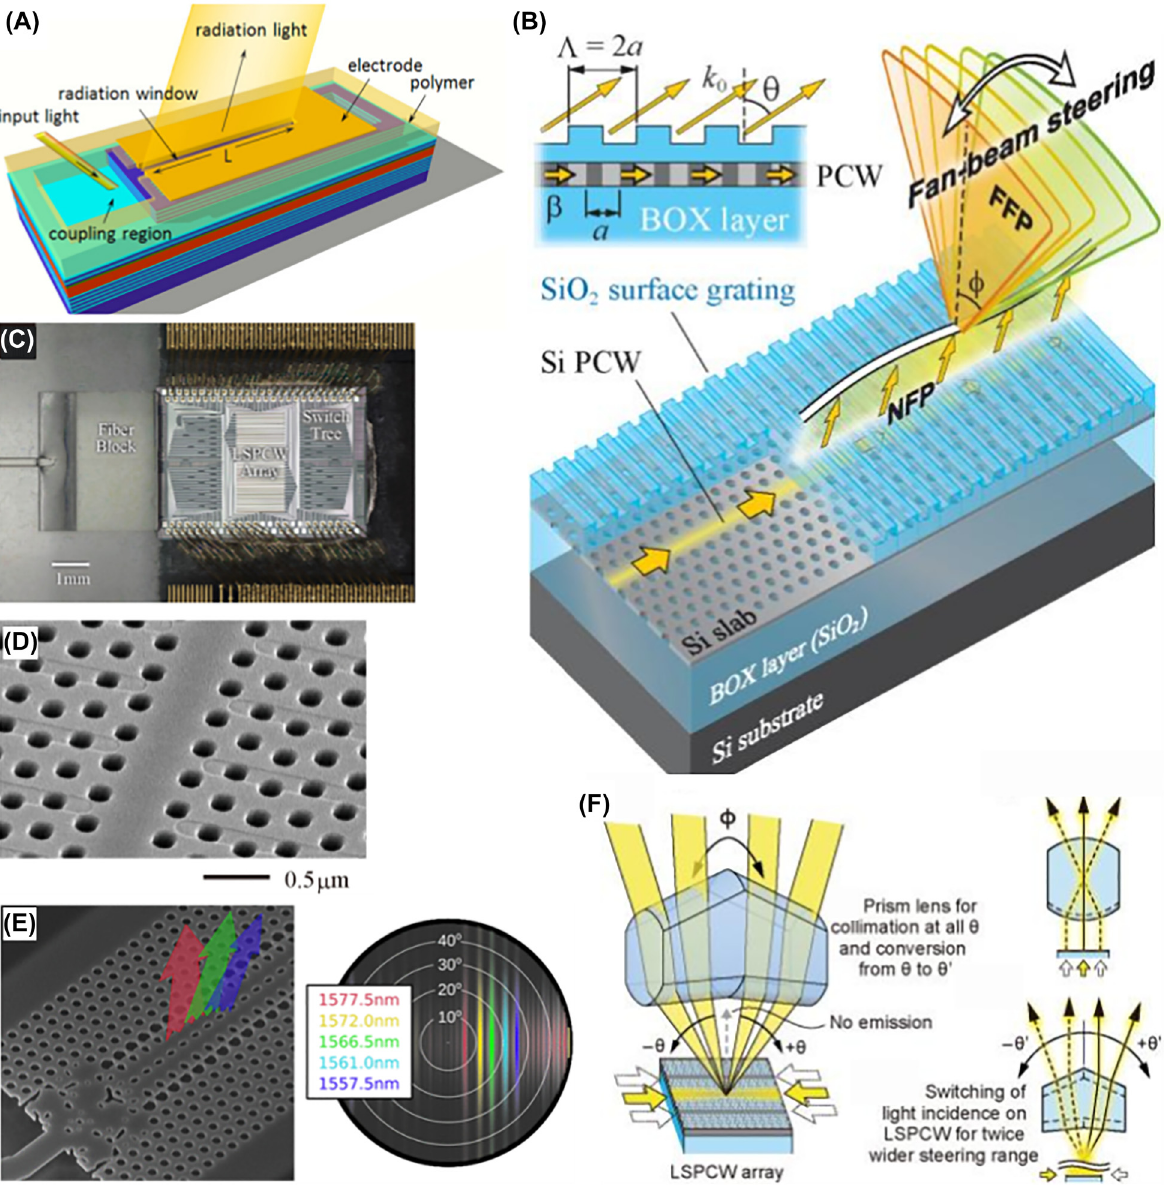
Figure 3: Slow light waveguide beam